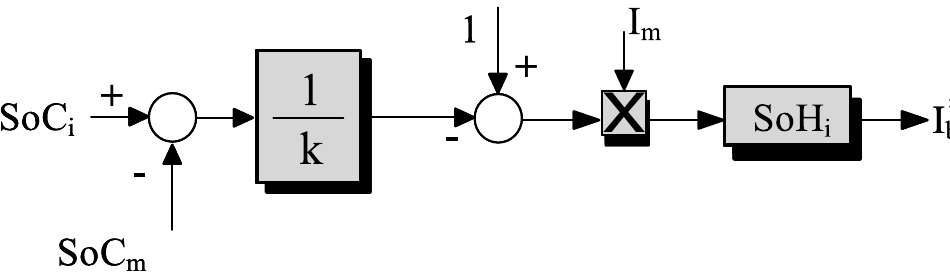
Figure 6. Block diagram of the adapted SoC